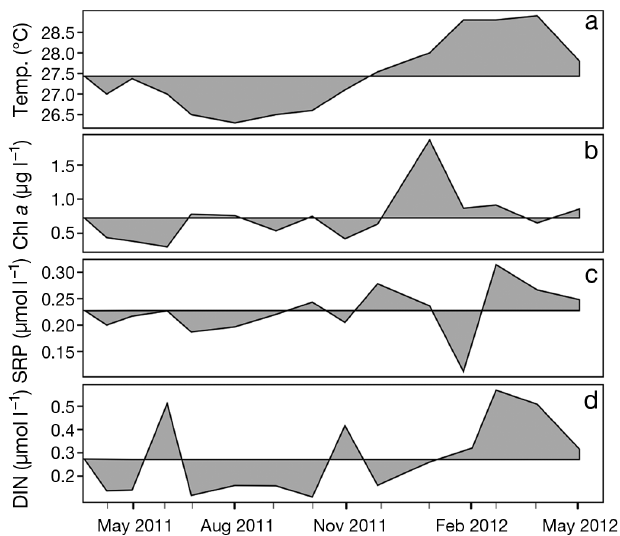
Fig. 3. Environmental parameters monitored in Tahiti be- tween April 2011 and May 2012. (a) Temperature; (b) chl a ; (c) soluble reactive phosphorus (SRP); (d) dissolved inor- ganic nitrogen (DIN). Horizontal line represents the annual mean, and shaded areas above or below the continuous line indicate periods with values higher or lower than the